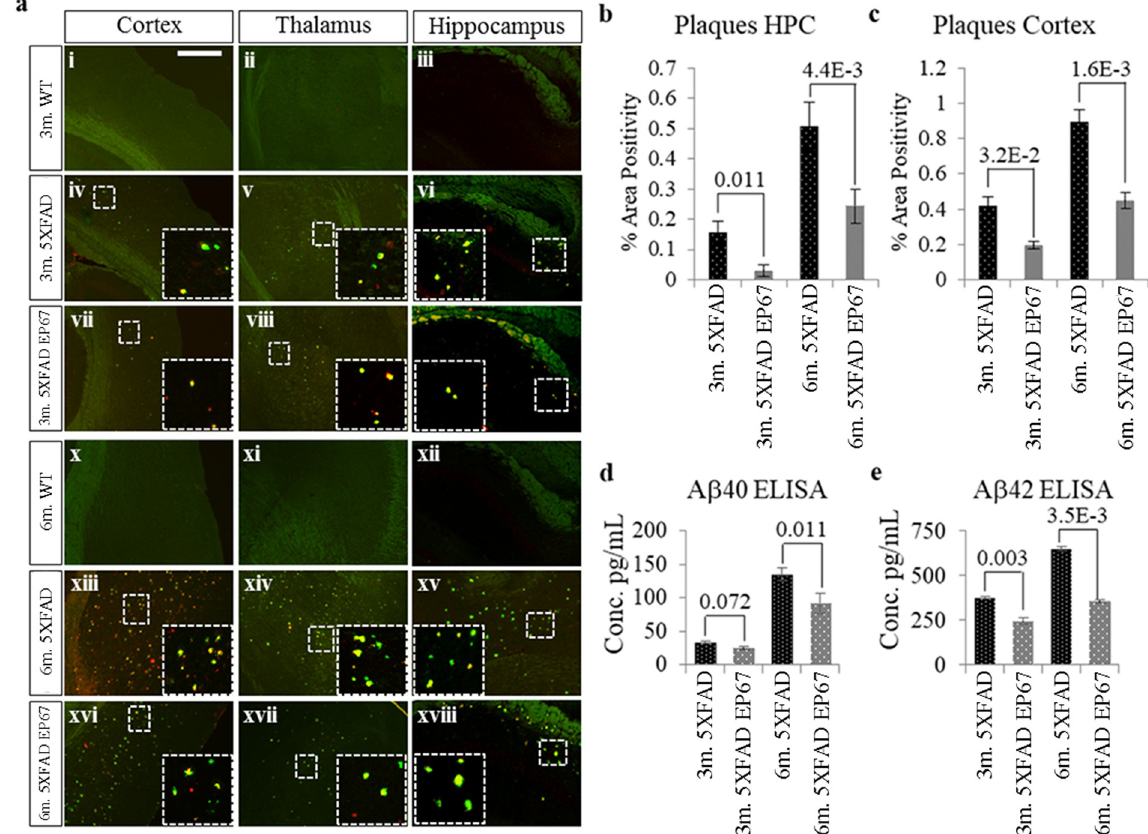
Fig 4. Amyloid plaques deposition. (a) Representative sagittal brain sections from 3 and 6 month old wild type mice (ai–aiii, x–xii respectively), 5XFAD (iv–vi, xiii–xv respectively) mice and 5XFAD mice treated with EP67 (vii–ix, xvi–xviii respectively). These sections were co-stained with Thioflavin-S (-green- excitation λ : 430 emission λ :550) and an anti-amyloid- β antibody (-red- excitation λ : 555 emission λ :580). Representative images of the cortex, thalamus and HPC are shown. Scale bar: 300 μ m. Serial sections were double stained with Thioflavin-S and an anti β -Amyloid antibody to quantify amyloid plaque deposition in the hippocampus (HPC) (b) and cortex (c) . n = 6/group/age. Mean ± 1SD. (d&e) Whole hemisphere brain homogenates from wild type, 5XFAD and 5XFAD mice treated with EP67 at ages 3 and 6 months were used to measure the amount A β 40 (d) and A β 42 (e) , n = 6/group/age.